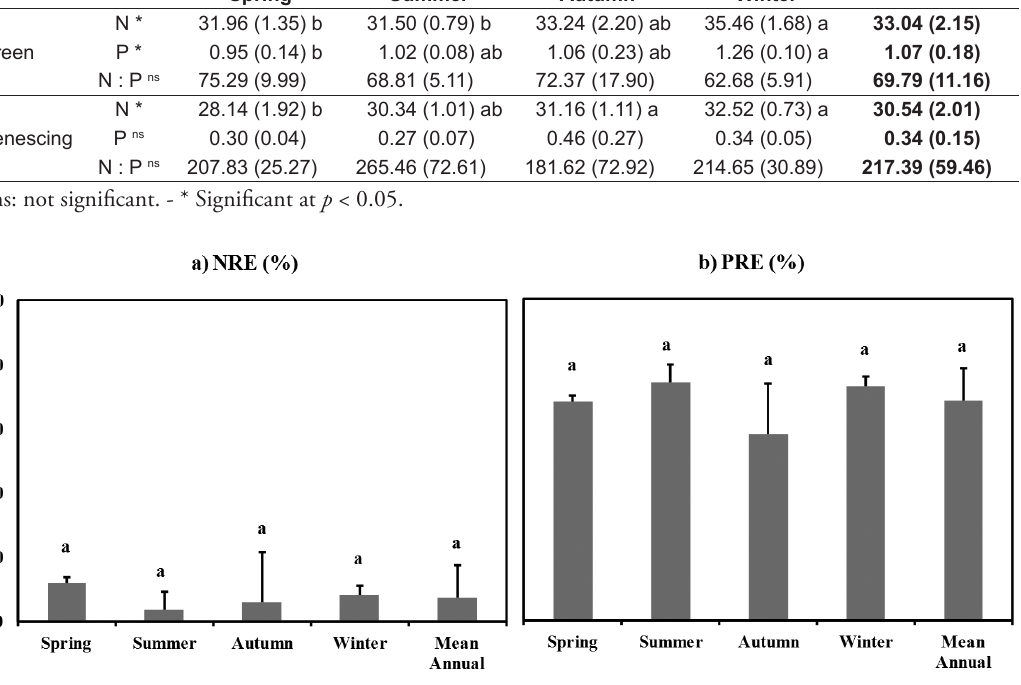
Figure 2. Fluctuation a) NRE and b) PRE for leaves of T. domingensis in four different seasons (Spring, Summer, Autumn and Winter) and Mean Annual. The bar indicates standard deviation. Identical letters indicate groups of means with no statistically significant differences at the 95% confidence